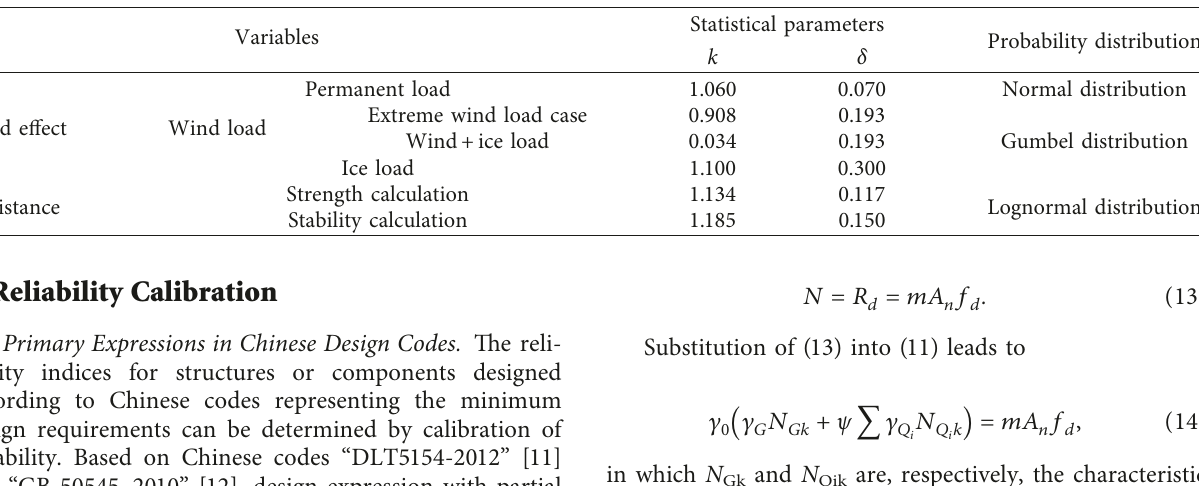
Table 4: Statistical parameters of load effect and resistance of transmission